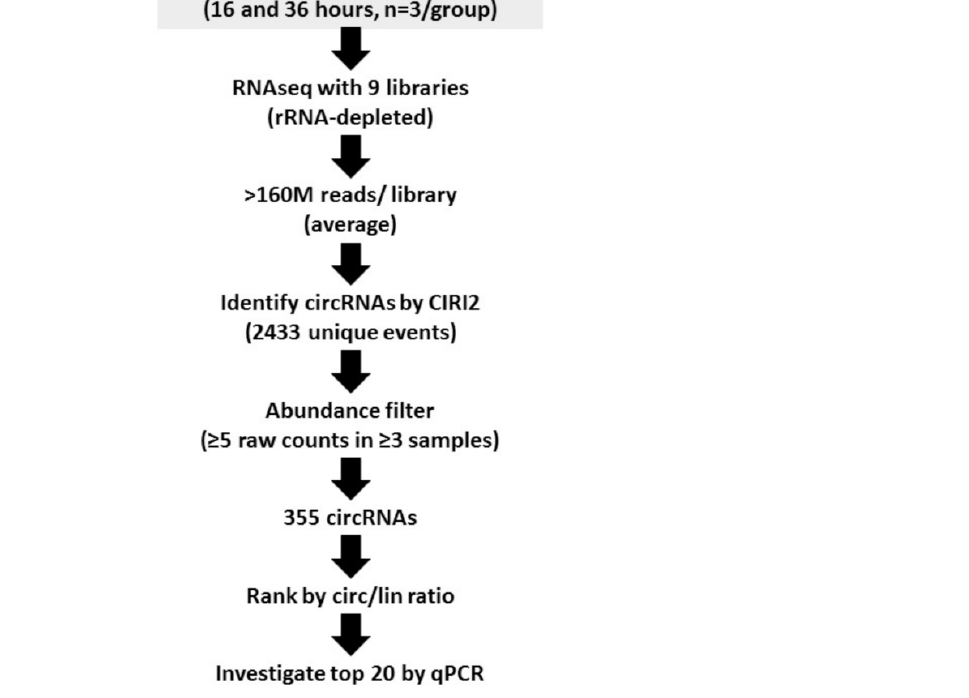
Figure 1. Bioinformatics pipeline for identification of circRNA expression in HUVEC exposed to oxidative stress. The experimental set-up of the previously published dataset (GSE104664) is shown together with applied software and subsequent filtering steps. HUVEC exposed to 16 h of solvent were used as